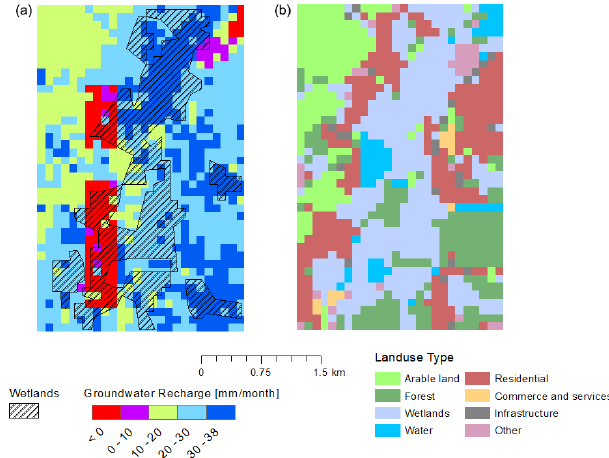
Figure 3. Monthly averaged delayed groundwater recharge from 1980 to 2013 estimated using WetSpaSS (a) and land cover class (b)